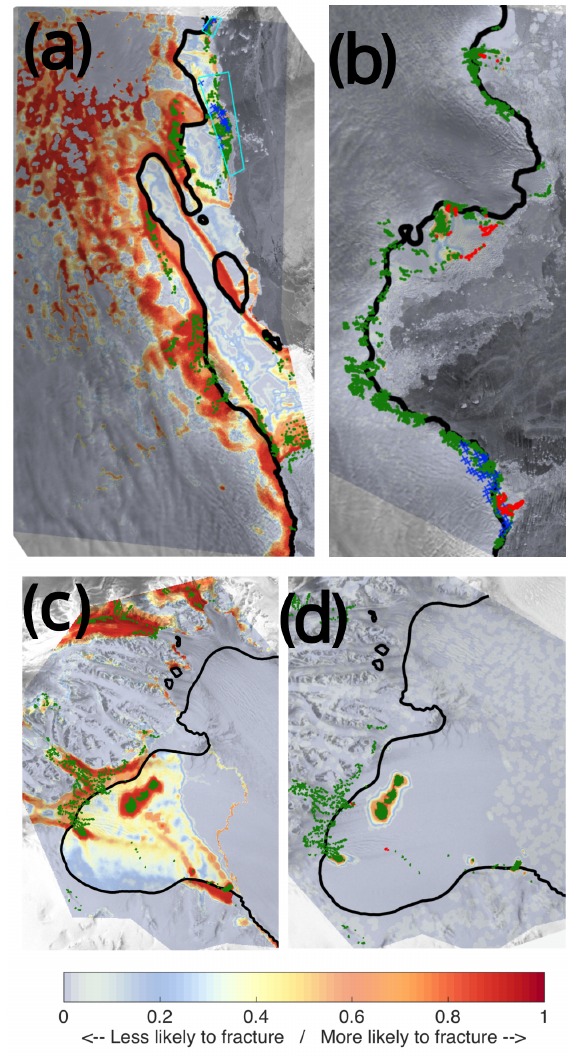
Figure 11. Modelled probability of a fracture vs. modelled dam- age for Moscow University IS (group 1) (a, b) and Larsen B IS (group 1) (c, d) . Labels are the same as in Figs. 5 and